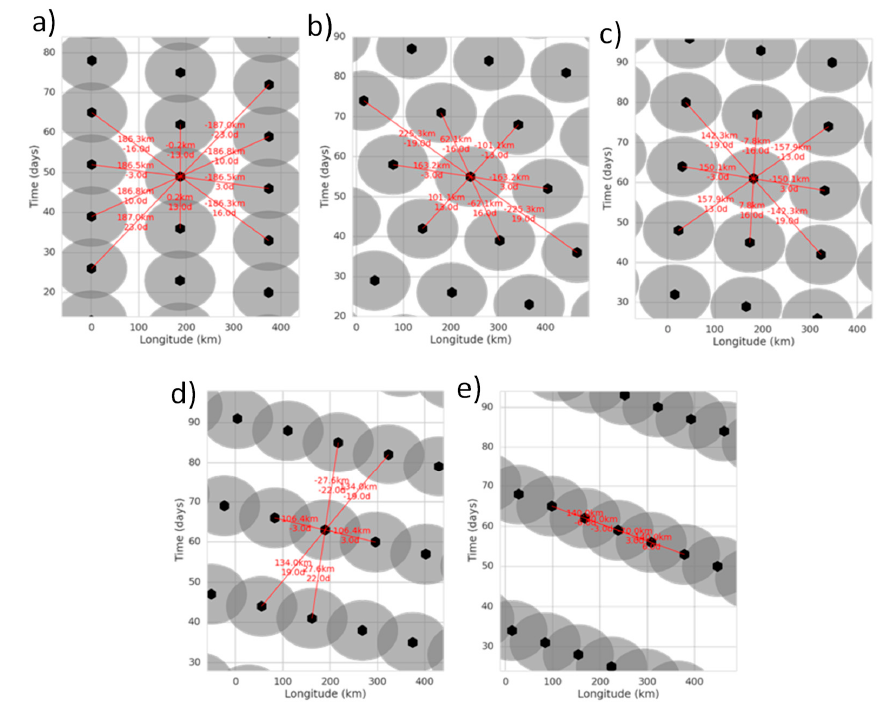
Figure 3. Same as Figure 1 for 5 altitudes near the historical ERS orbit. Panel ( a ) is approximately +2 km with respect to the ERS orbit. Panel ( b ) is approximately +1 km. Panel ( c ) is approximately +0.5 km. Panel ( d ) is approximately − 1.5 km. Panel ( e ) is approximately − 2.5 km. The alignment of gray circles (i.e., mesoscale-relevant orbit sub-cycles) is very different even though these 5 altitudes are relatively close to the ERS orbit.